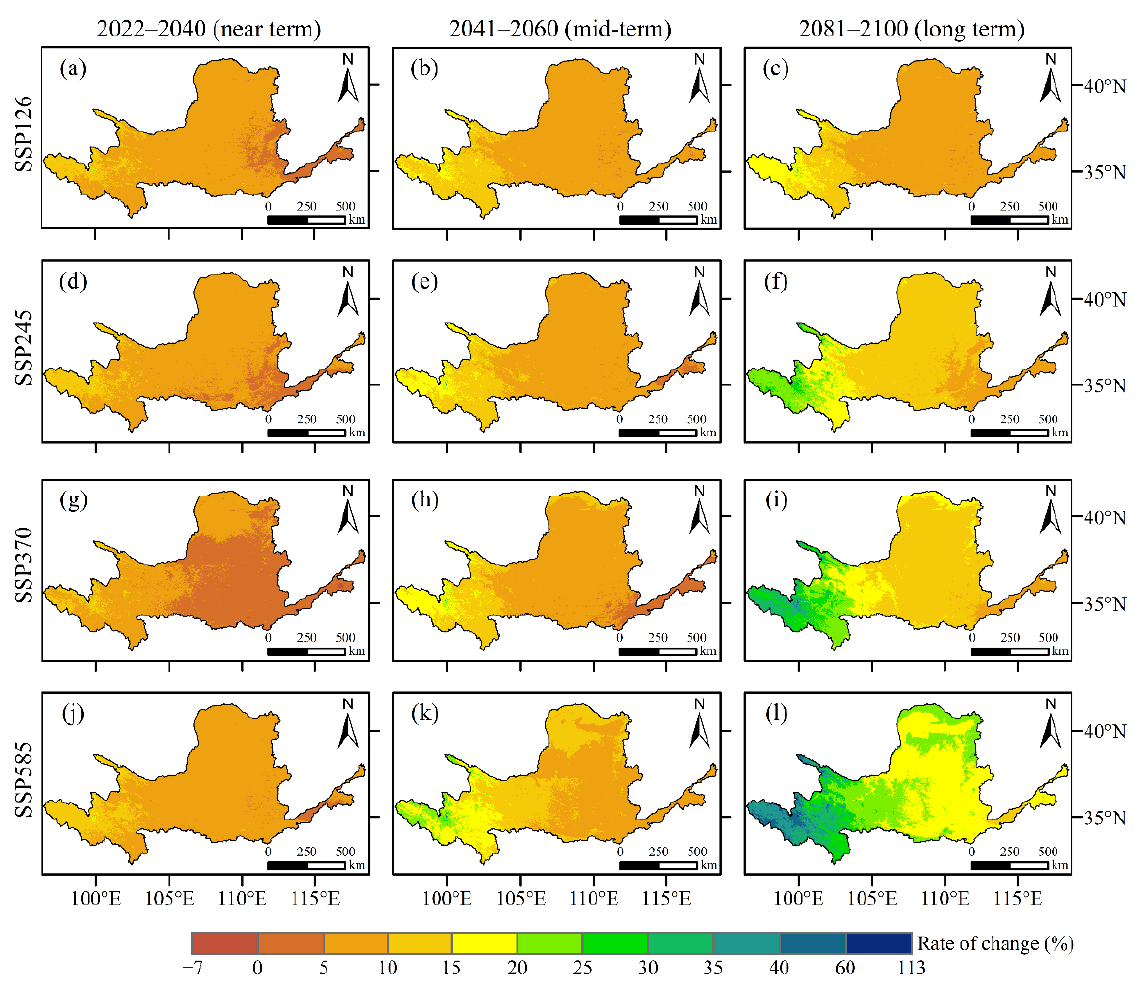
Figure 12. Spatial variations in the near (2022–2040; a , d , g , j ), mid- (2041–2060; b , e , h , k ), and long (2081–2100; c , f , i , l ) term future annual ET 0 of the Yellow River Basin relative to the historical period (1901–2014) under four SSP scenarios (SSP126, SSP245, SSP370, and SSP585).